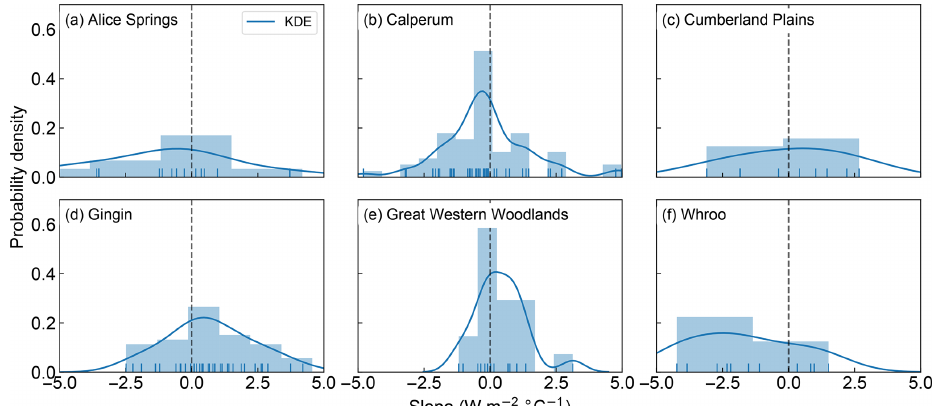
Figure 4. Probability density and histogram showing the distribution of fitted positive and negative LE slopes across the OzFlux sites. The dark blue curve shows the fitted kernel density estimate (KDE) and the vertical blue lines along the x axis are “rugs”, which represent the individual occurrence of fitted slopes. Data from Wombat State Forest have been omitted from the graph as there was only one slope. Note that the sum of the bars can exceed 1 as the normalization ensures that the sum of the bar heights multiplied by the bar widths equals 1, which allows the normalized histogram to be compared to the KDE, which is normalized so that the area under the curve equals